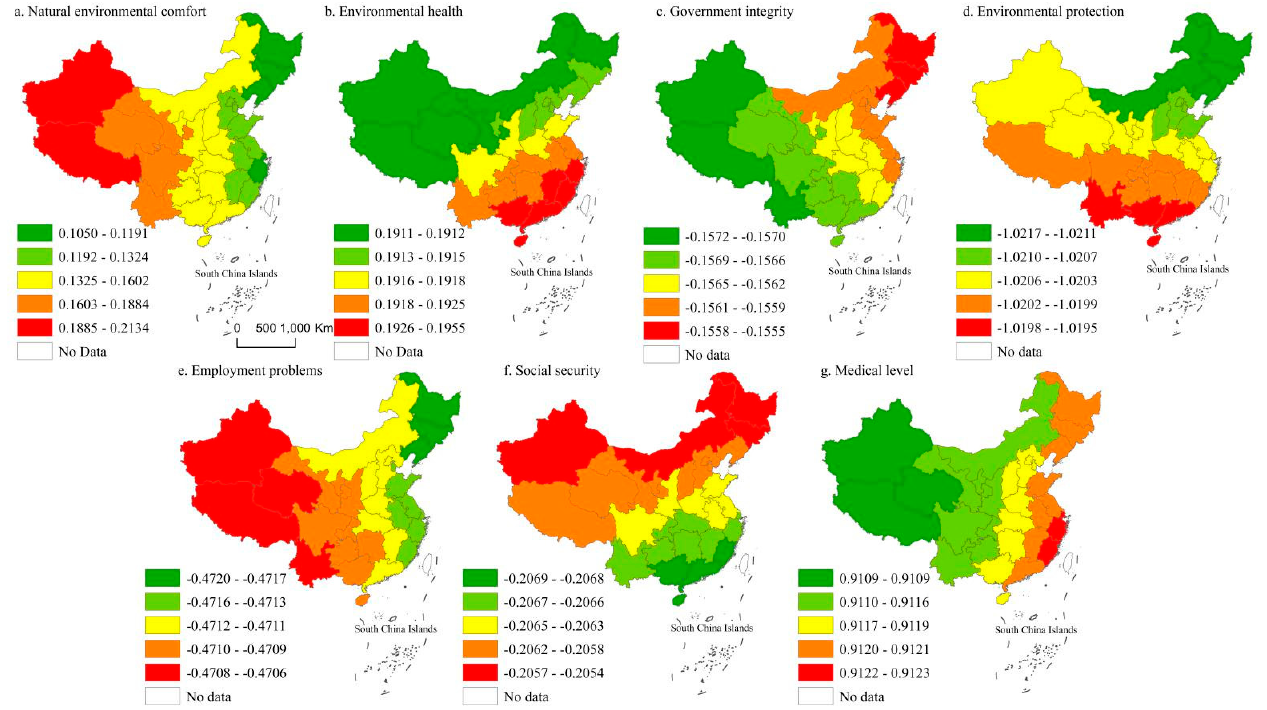
Figure 5. Spatial distribution of the regression coefficients estimated for significant variables.